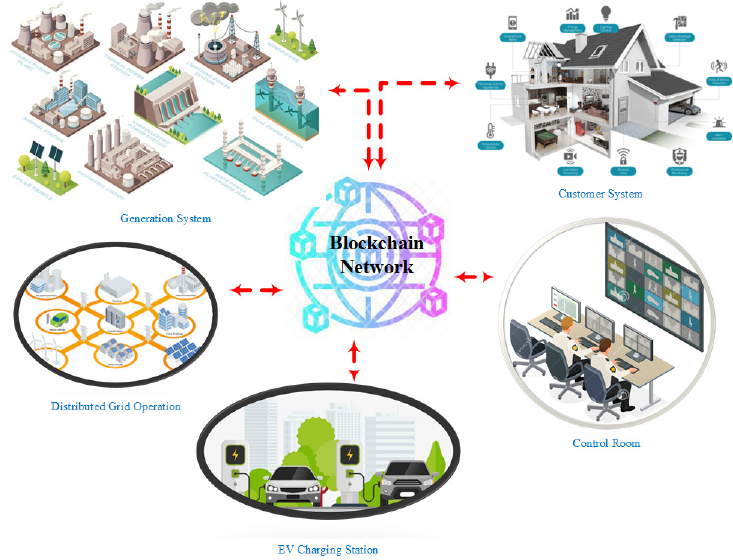
Figure 7. Blockchain architecture used by an EMS. Table 2. Applications of blockchain technology in different SG